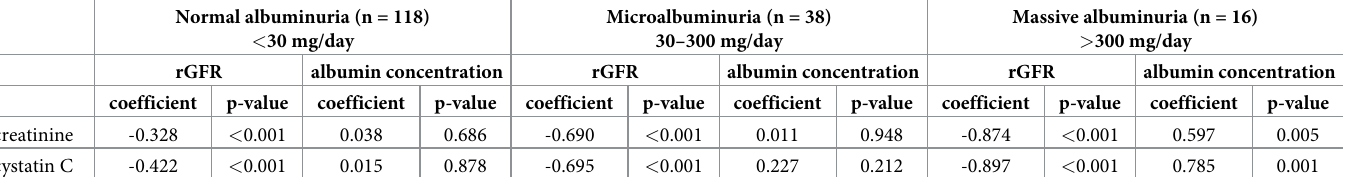
Table 3. Comparison of the correlations of the biochemical parameters of creatinine and cystatin C with rGFR and albuminuria after stratification on the basis of the severity of albuminuria. Normal albuminuria (n = 118) < 30